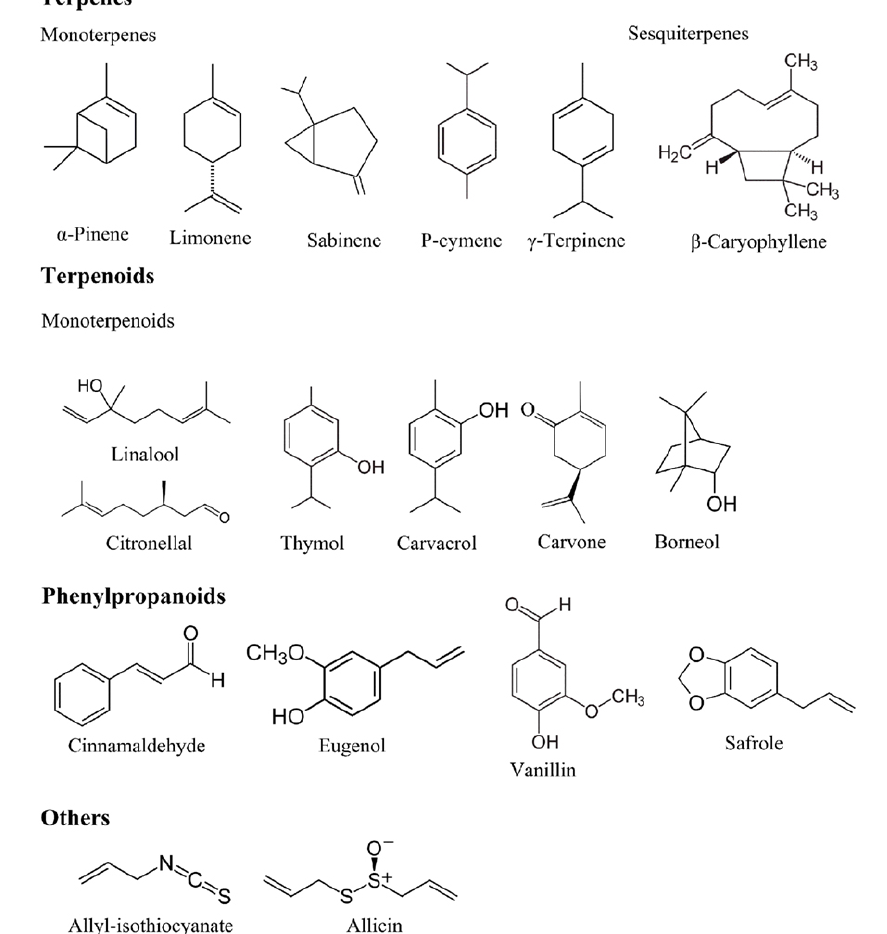
Figure 1. The chemical structure of antibacterial bioactive compounds in herbs [56]. Potential application of herbs in dairy